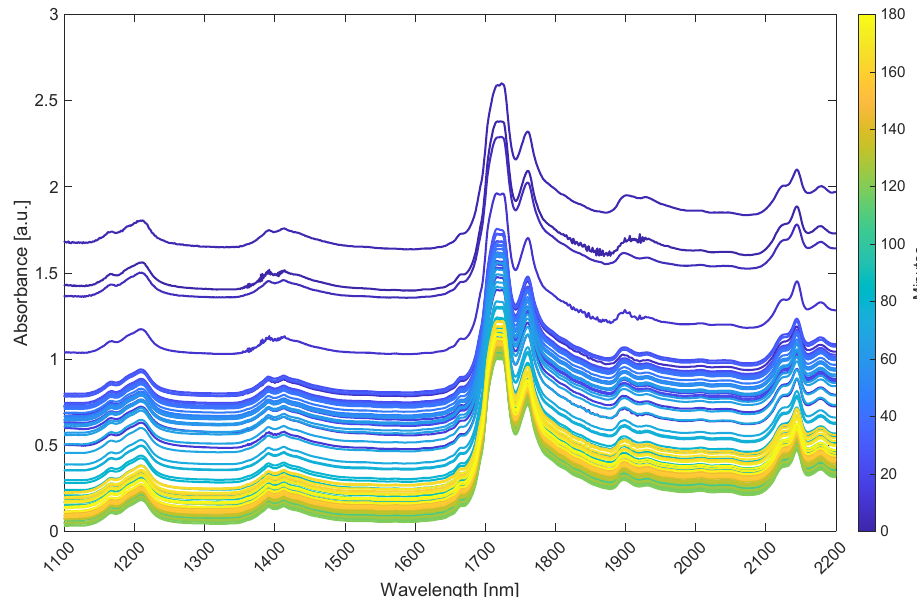
Figure 4. Single scan NIR spectra of batch A colored by time. Every 50th spectrum is plotted for clarity.